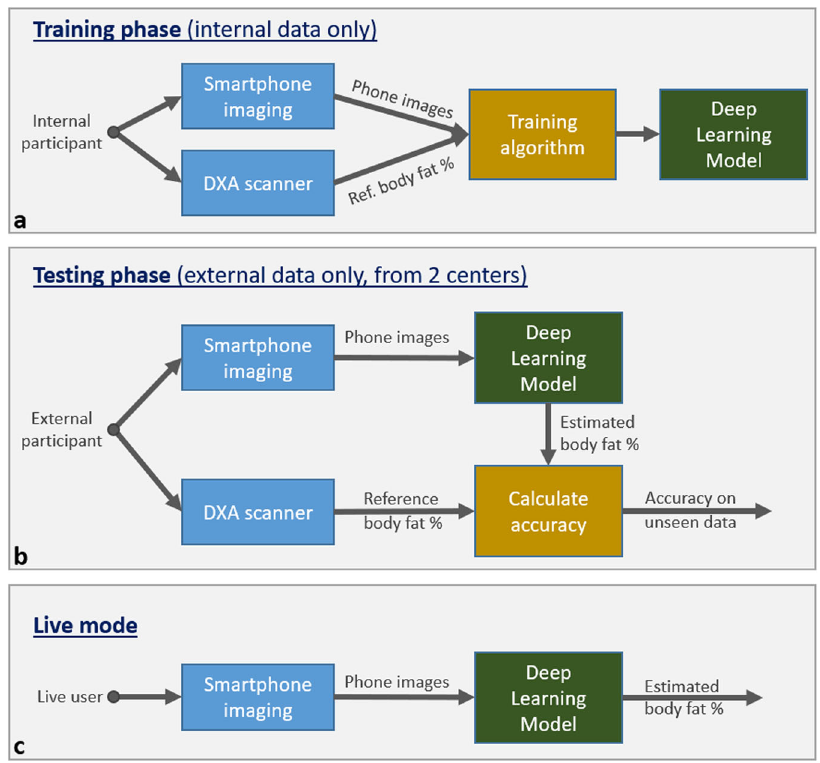
Fig. 7 Different phases of our algorithm. Block diagrams illustrating the data fl ow for different phases of our algorithm: training a , testing b , and live use c . DXA images are never